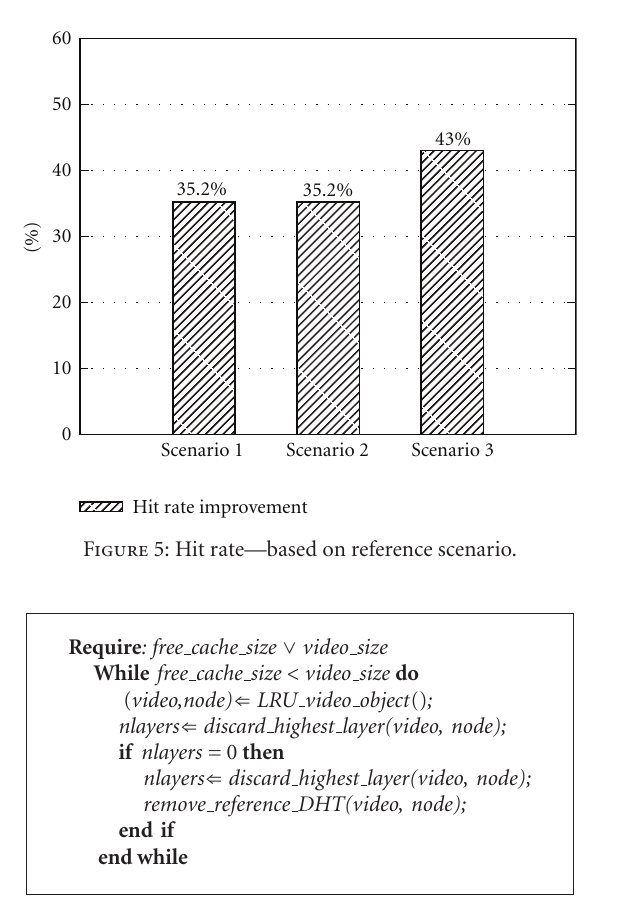
Algorithm 4: Discarding layers, the global